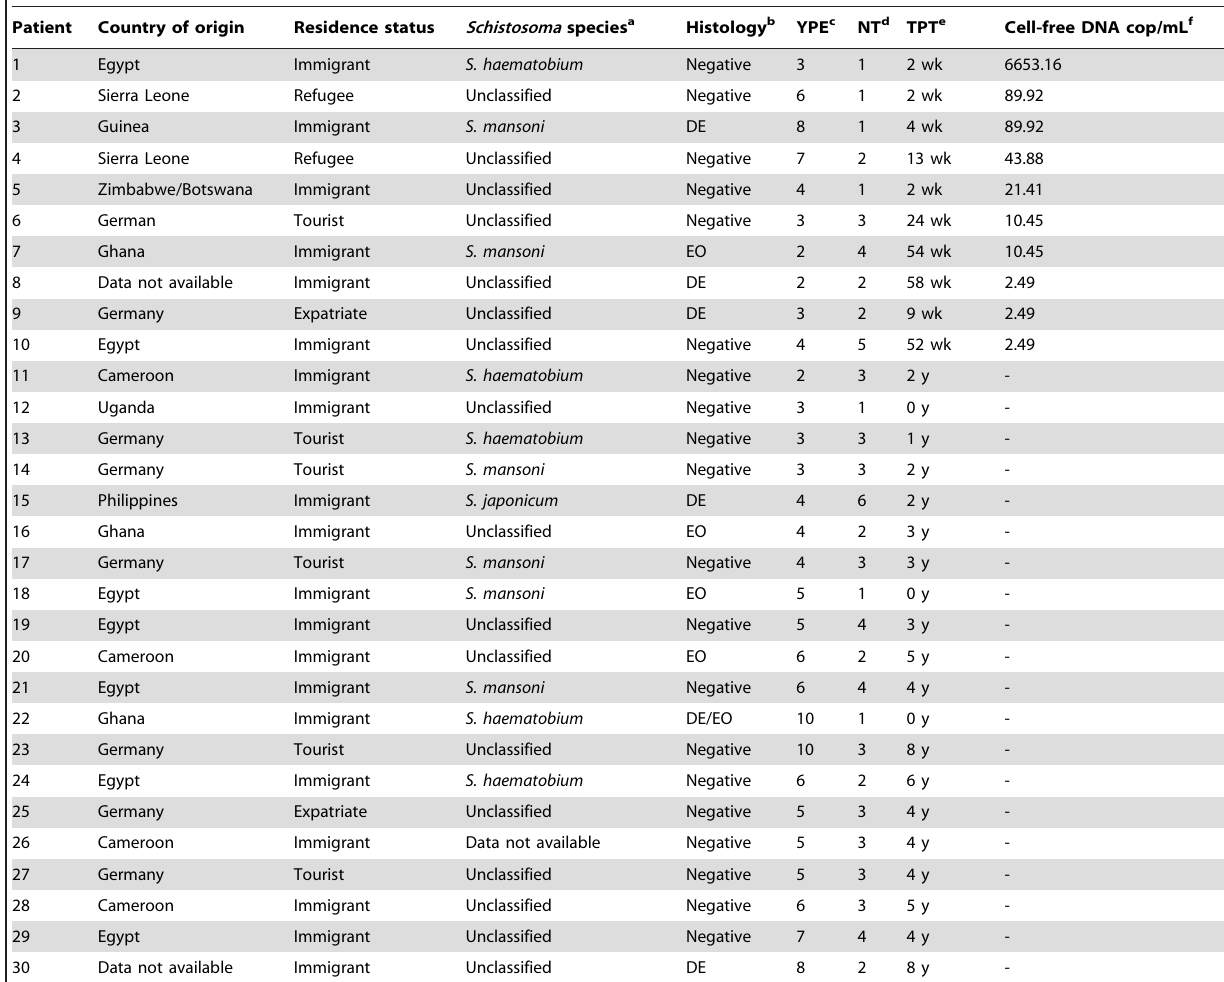
Table 3. Patients seen after